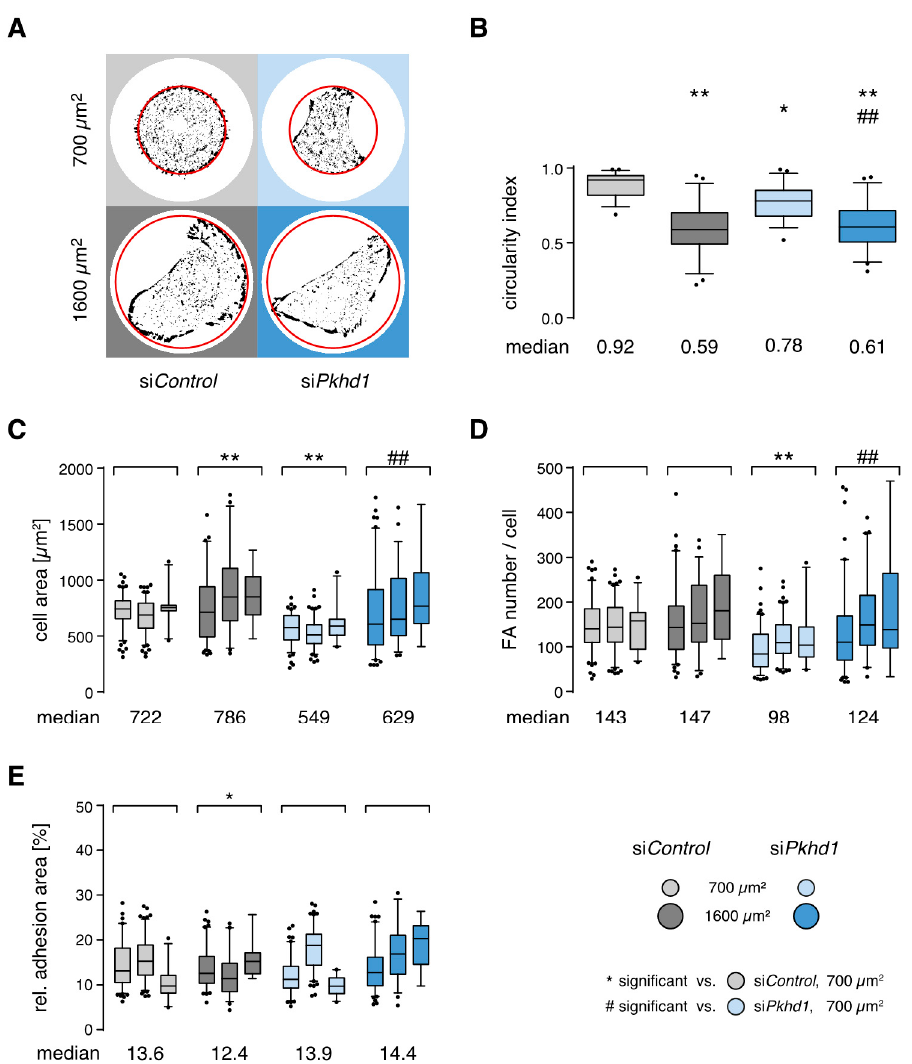
Figure 2. E ff ects of FPC deficiency and confinement on cell shape and adhesion sites. ( A ) Representative cell shape and adhesion sites of siRNA-treated cells. Four hours after seeding onto collagen-coated micropatterns, cells were fixed and stained for vinculin to mark cell–ECM adhesions. Red line indicates the outline of disk-shaped adhesion area; diameter size: 30 and 45 µ m for 700 and 1600 µ m 2 pattern, respectively. ( B ) Cell geometry determined by relation of short to long cell axis (circularity index). All box plots with whiskers 5 / 95% ( n = 50 cells per condition, two-way ANOVA / Tukey’s). ( C – E ) Spreading area, number of adhesion sites per cell and relative adhesion area extracted from fluorescence images of steady-state adhesion for FPC-deficient cells and controls in spheroid culture conditions. ( n = 3 independent experiments, > 250 / 170 cells per condition for 700 / 1600 µ m 2 ; two-way ANOVA / Tukey’s, p < 0.05 / 0.01, * / ** or # / ## .)